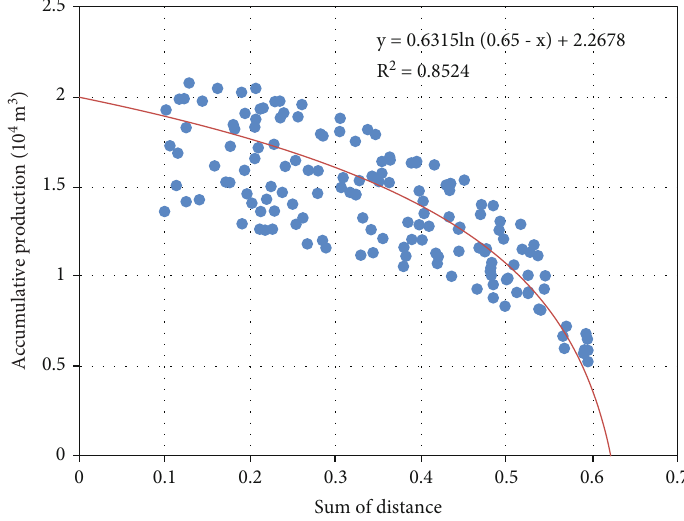
Figure 4: The distance sum and cumulative production for 154